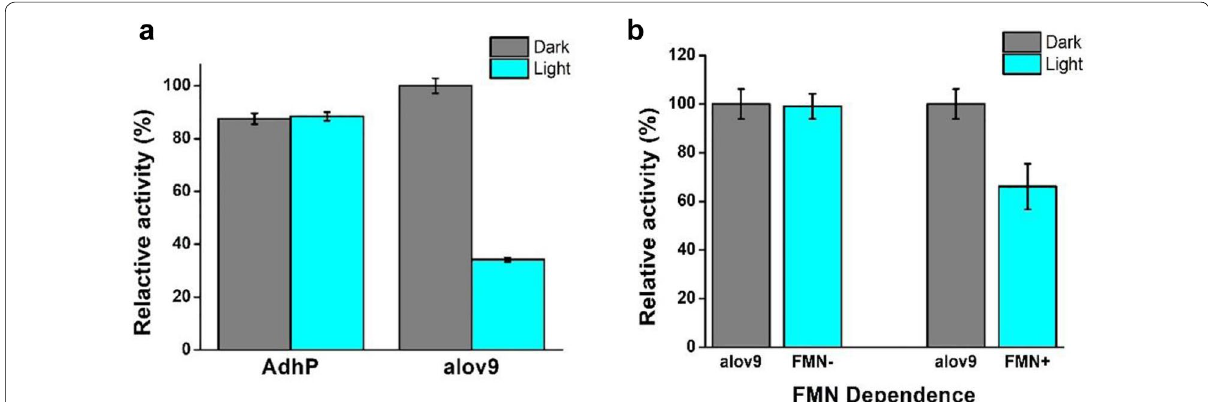
Fig. 2 Optical suppression of alov9 protein. a Enzyme activity assay shows that alov9’s catalytic activity is inhibited upon irradiation. b Dependence of alov9 protein on cofactor FMN. Under the experimental conditions, the relative activity was expressed as a percentage of the maximum activity